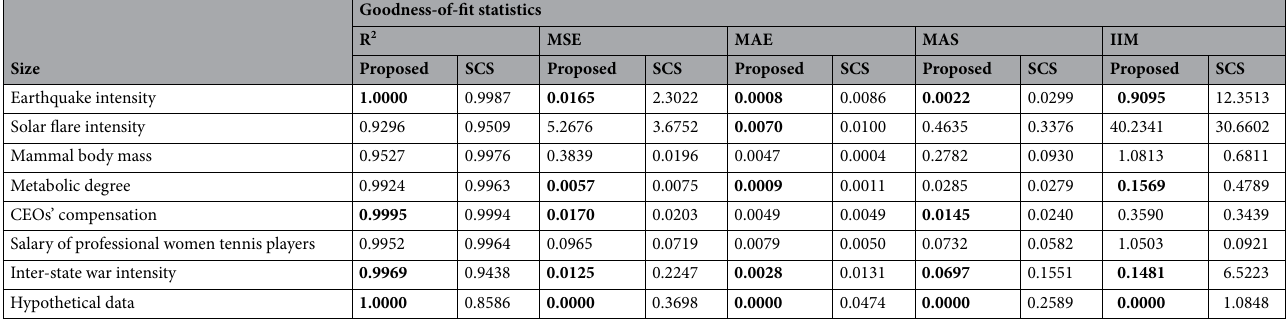
Table 4. The evaluation of performance of the proposed model and that of the SCS model based on five goodness-of-fit statistics. The bold numbers indicate that the proposed model is superior to the SCS